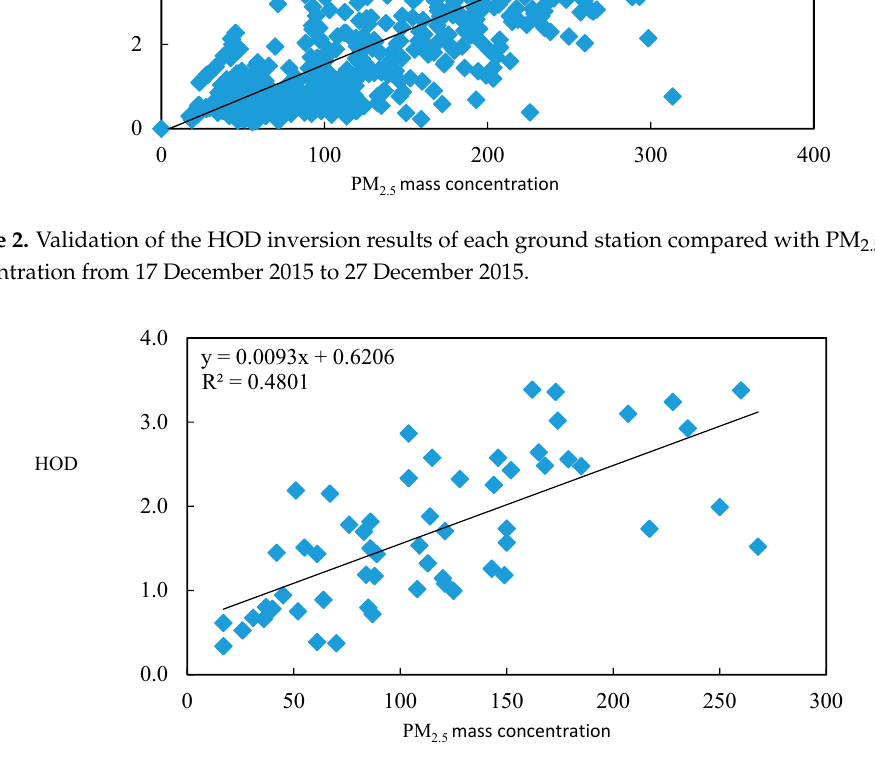
Figure 3. Validation of the regional average HOD inversion results compared with PM 2.5 mass